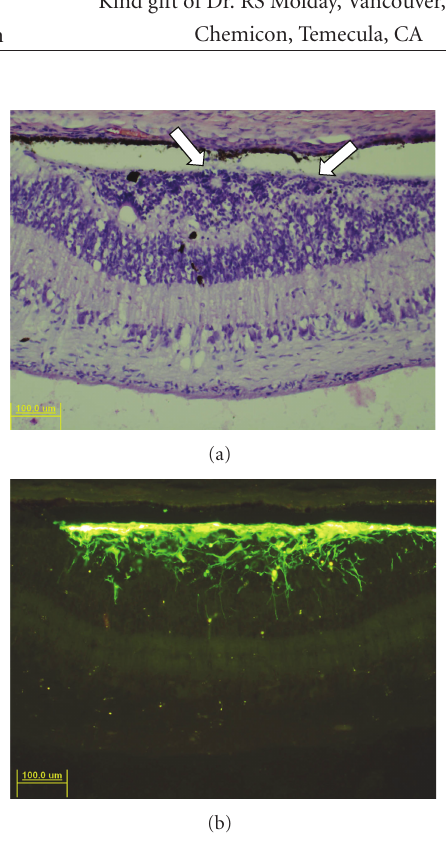
Figure 2: Engraftment of RPCs in rhodopsin Pro347Leu recipient. Recipient was 6 weeks of age at time of transplantation. (a) H&E stained section through the graft site 5 weeks after transplantation shows a cellular mass in the subretinal space of presumptive donor origin. Artifactual detachment of the retina reveals the cellular mass to be adherent to the outer surface of the retina, in preference to the adjacent RPE layer. A number of photoreceptor rosettes are present within the cellular mass (arrows), as well as some focal pigment profiles, some of which are also found within the adjacent host neural retina. (b) Fluorescence imaging shows intense GFP- associated immunoreactivity in the subretinal space, corresponding to the cellular mass noted with H&E, above, thereby confirming the identity and location of the graft. A presumptive rosette is visible within the center of the graft, in a location similar to that seen in the H&E section. The majority of GFP+ cells remain in the subretinal mass; however, a number of donor cells are visible within the host retina and these have processes that exhibit a high degree of radial